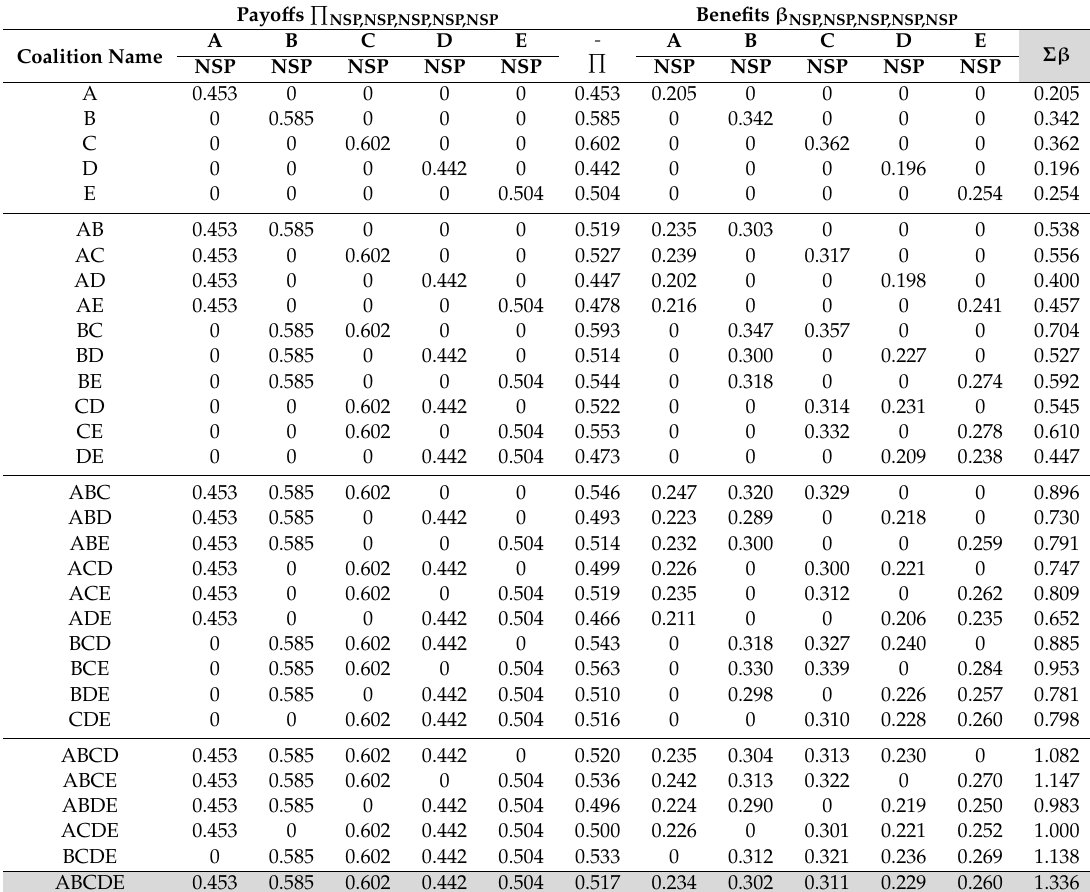
Table 13. Coalitions of stakeholders for obtained Nash